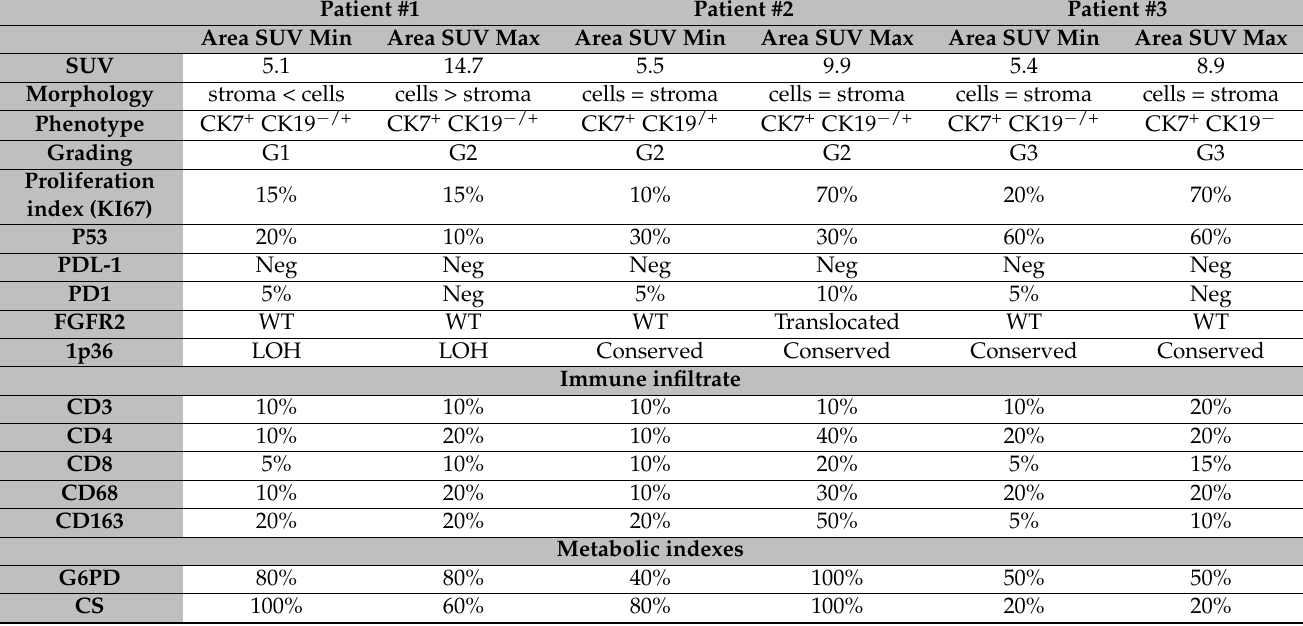
Table 2. Summary of the pathology